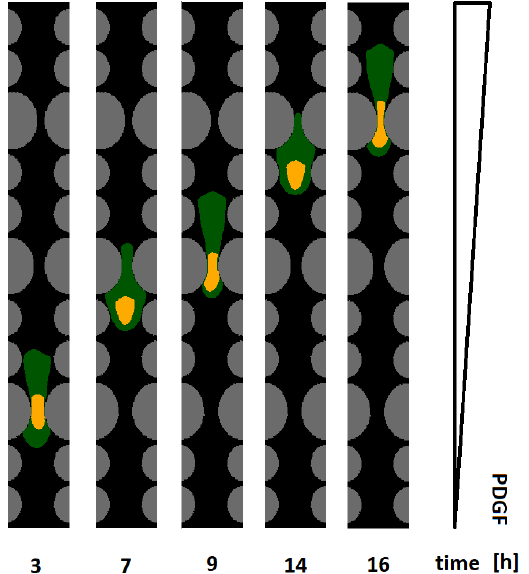
Figure 7. Simulation image sequences of cell invasion within a representative migratory channel characterized by d 1 = 5, d 2 = 3, and d 3 = 2 µ m. The virtual individual had an enhanced nuclear elasticity (i.e., ν N = 0.7) that allowed full invasion in approximately 40% of cases (see Figure 6B). The initial diameter of the cell nucleus was d N = 16 µ